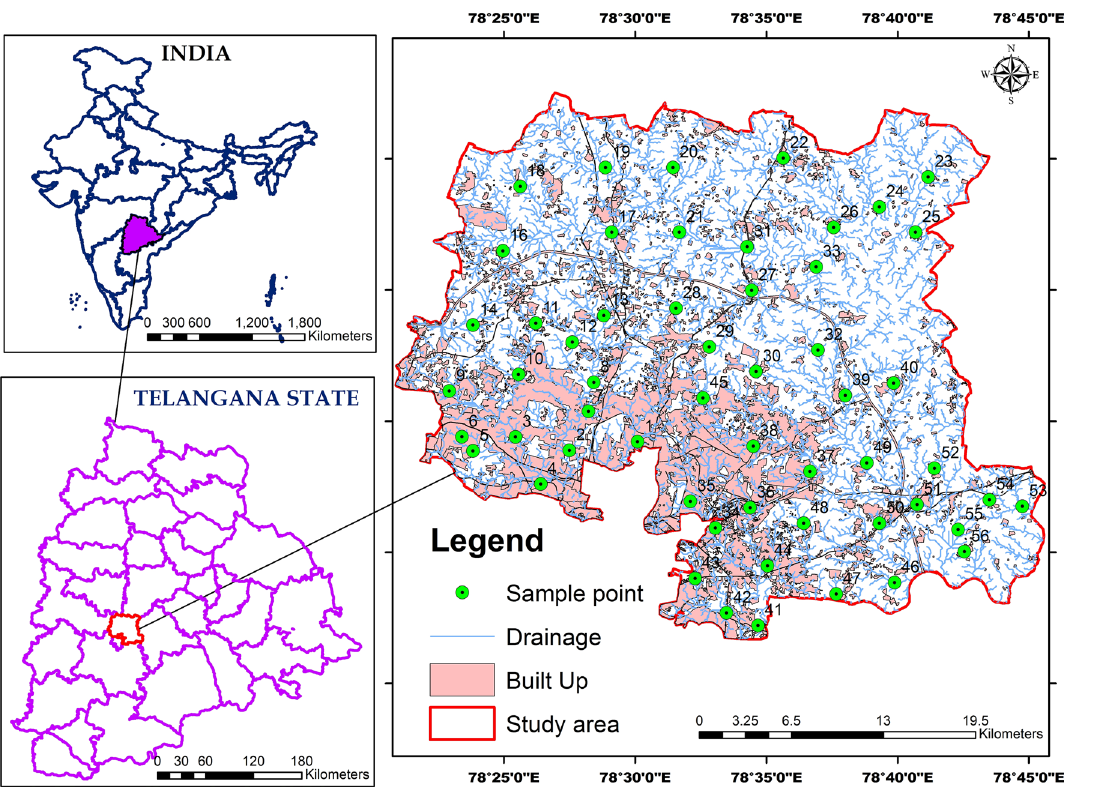
Fig. 1 Study area with sample